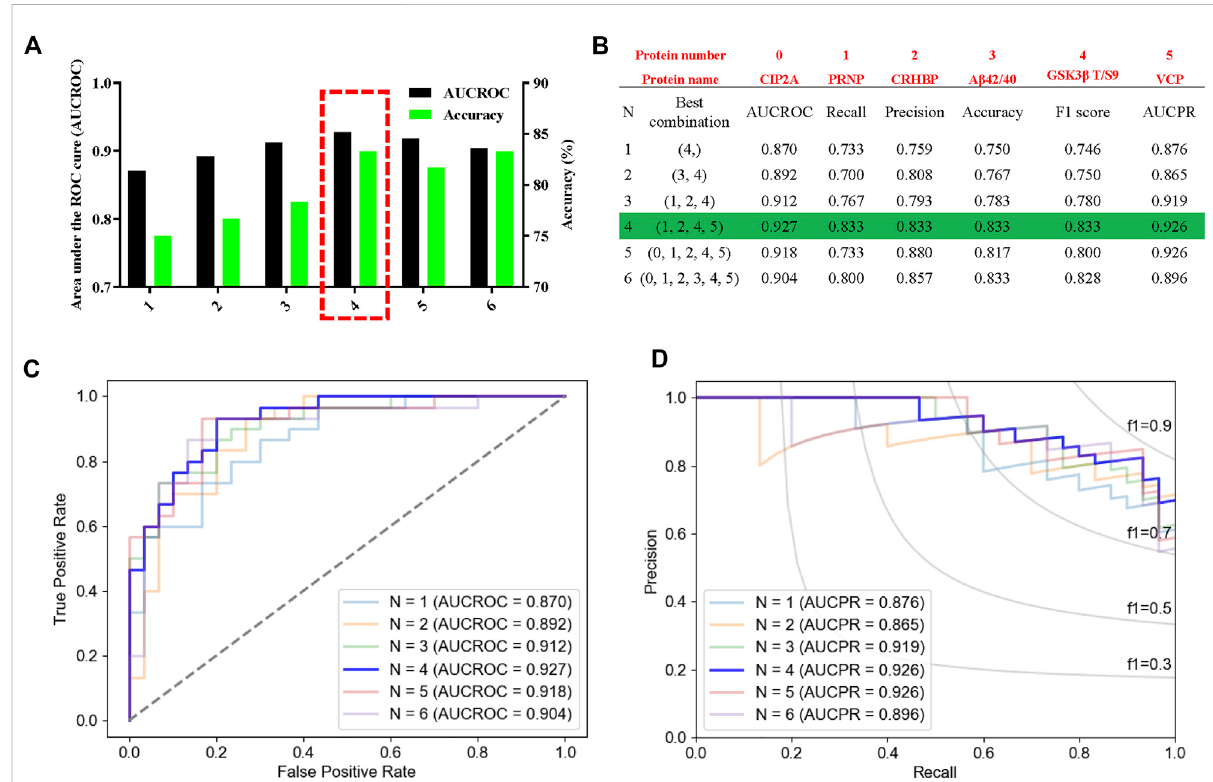
FIGURE 7 High performance discrimination of T2DM-MCI from T2DM-nMCI achieved by machine learning. (A) ROC area and corresponding accuracy based on the leave-one-out (LOO) algorithm in the validation set. The red box shows the selected protein with high area under the curve (AUC) and accuracy for the blinded test set. (B) Corresponding protein and various parameters for evaluating the ef fi ciency of the biomarkers under each best combination. Red numbers represent the corresponding protein. (C,D) Based on the LOO algorithm, the area under the receiver operating characteristic curve (AUCROC) and precision – recall curve (AUCPR) for each best combination of biomarkers. AUCROC was based on the true- positive rate and false-positive rate: True-positive rate = [true-positive/(true-positive + false-negative)], False-positive rate = [false-positive/(true- negative + false-negative)]. PRAUC was obtained based on precision and recall: Precision = [true-positive/(true-positive + false-positive)]; Recall = [true-positive/(true-positive + false-negative)]. In addition, F1 score = 2 * (precision * recall)/(precision +